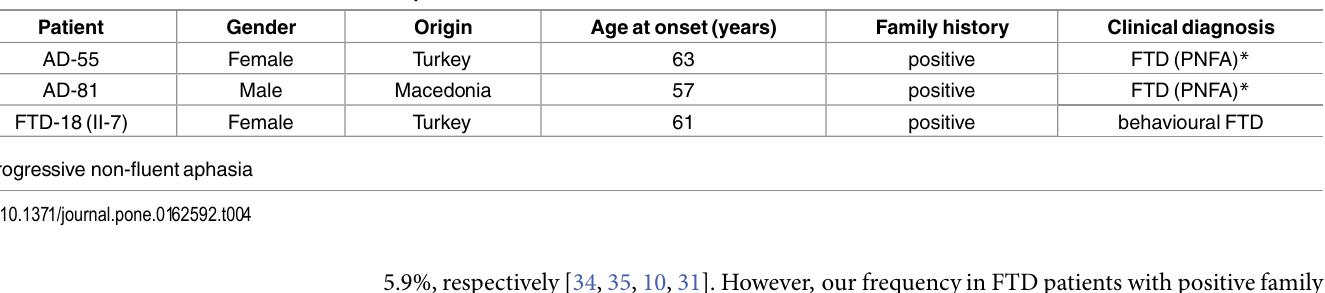
Table 4. Clinicalinformation of the C9ORF72 expansion